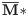
Knee joint angles and displacements, U = [θ1
θ2
θ3
d1
d2
d3]T for both subjects.Model-derived kinematics estimated with the four knee joint models: no joint model (N, red), spherical model (S, yellow), parallel mechanism (P, green), and stiffness matrix (M, cyan) plotted against fluoroscopy-based kinematics (Ref, black). Sensitivity analysis results are represented by the mean of the kinematics estimation over the 511 runs of MBO embedding perturbed stiffness matrices (M¯*, dark blue), with corridor representing the variation in the estimation for one standard deviation (light grey, M¯*±sd) and 1.96 standard deviation (M¯*±1.96sd, dark grey) around the mean value.